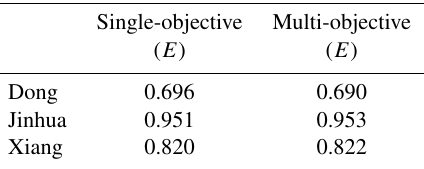
Table 1. Comparison of the best E values obtained with single- objective calibration and multi-objective calibration ( E –RD strat-